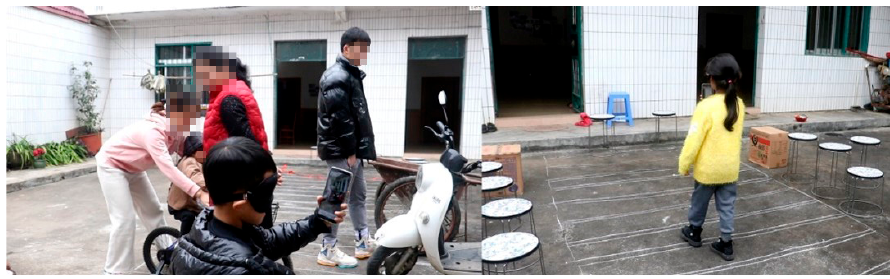
Figure 10. Photos of the inter-group comparative experiment. In this experiment, participants in the intervention group reached the finish line dur- ing the green light. The authors screened the refined relevant experimental data and sorted the suitable and effective mobile data into the path graph shown in Figure 11. In the figure, purple represents the planned path, the red box represents the end range, and other colors represent the movement paths of six subjects in the intervention group. All blindfolded participants could move from the starting point to the endpoint, and some encountered roadside obstacles. The subjects were informed that they had suddenly lost their direction in the middle of the test and had finally found their original direction after coming in contact with obstacles.